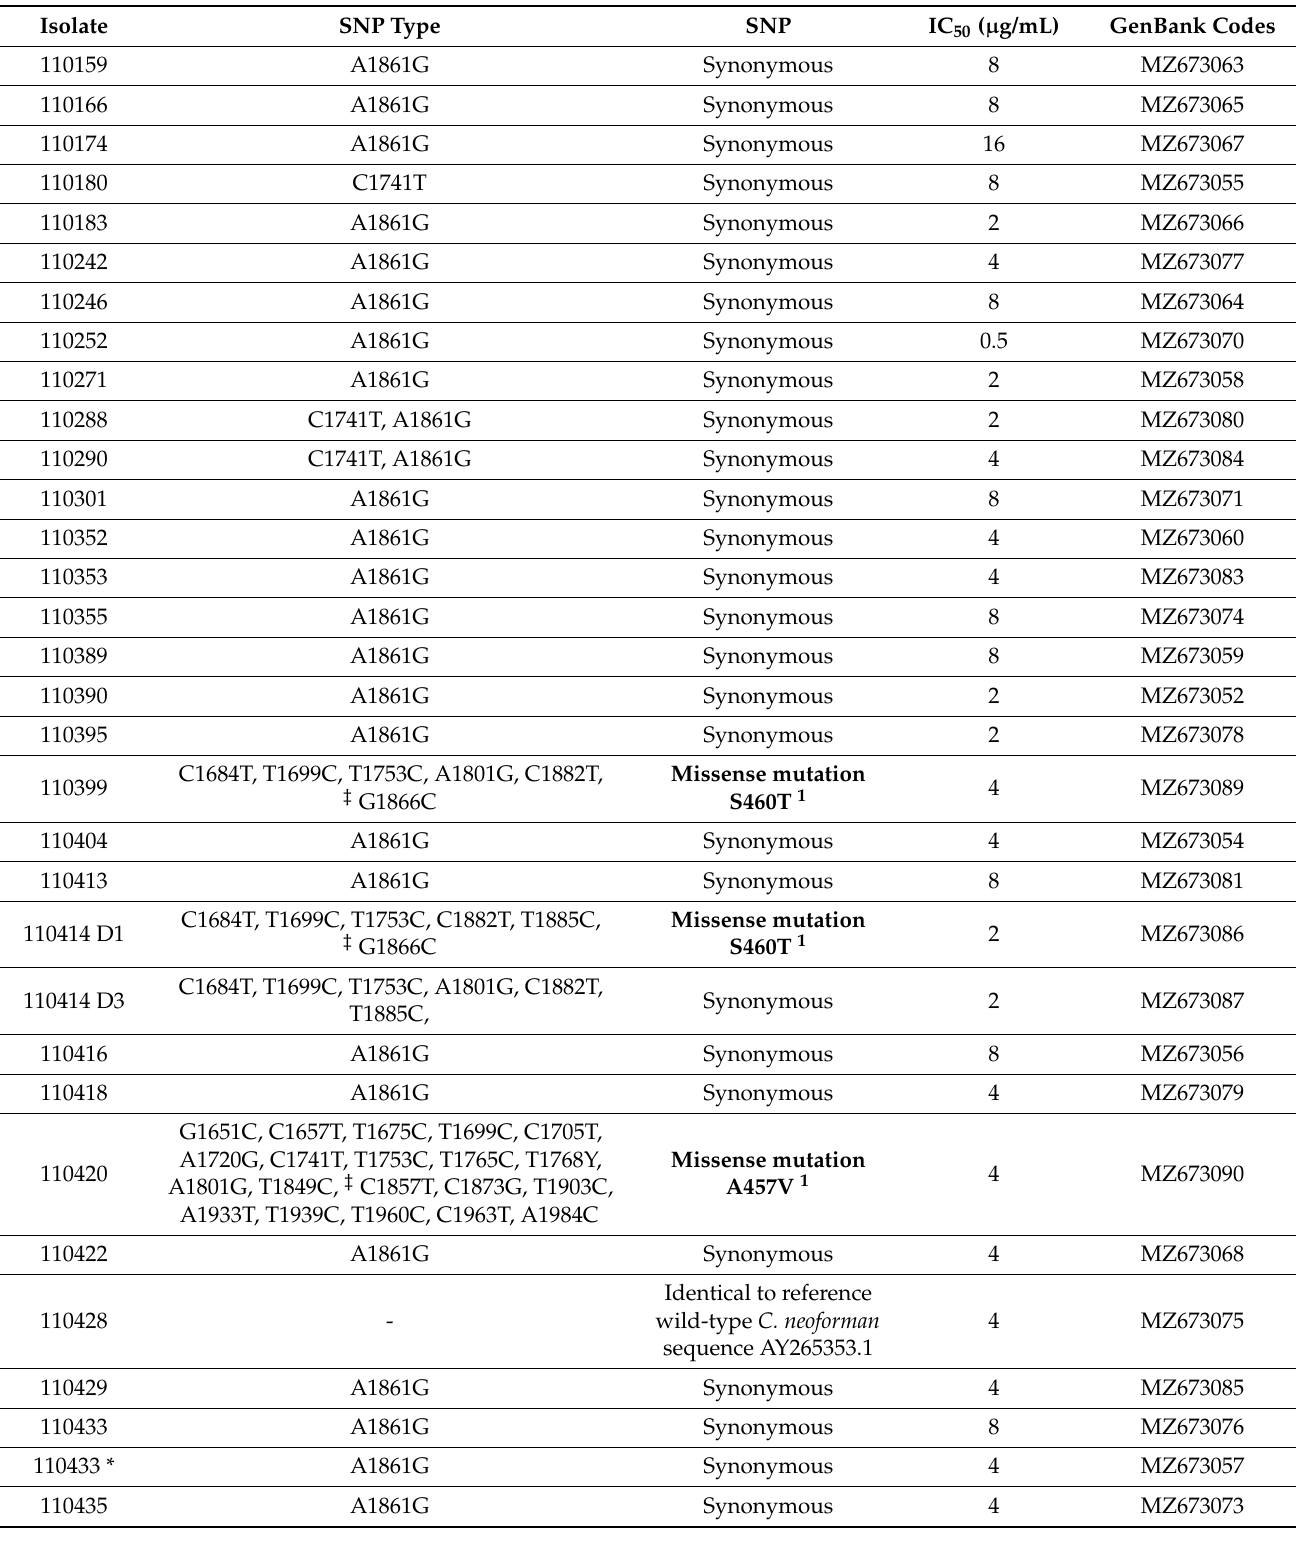
Table 3. Single nucleotide polymorphisms (SNPs) in the partial ERG11 gene-coding region from 40 C. neoformans clinical isolates show no association with fluconazole IC 50